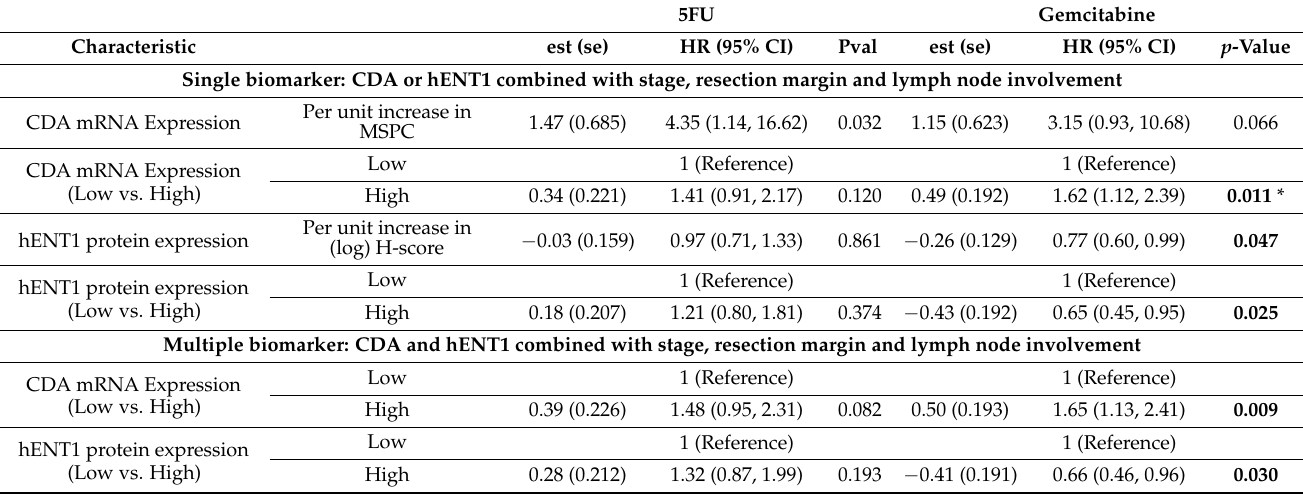
Table 2. Cox regression analysis of biomarkers in the 5-FU and gemcitabine arms. 5FU Gemcitabine